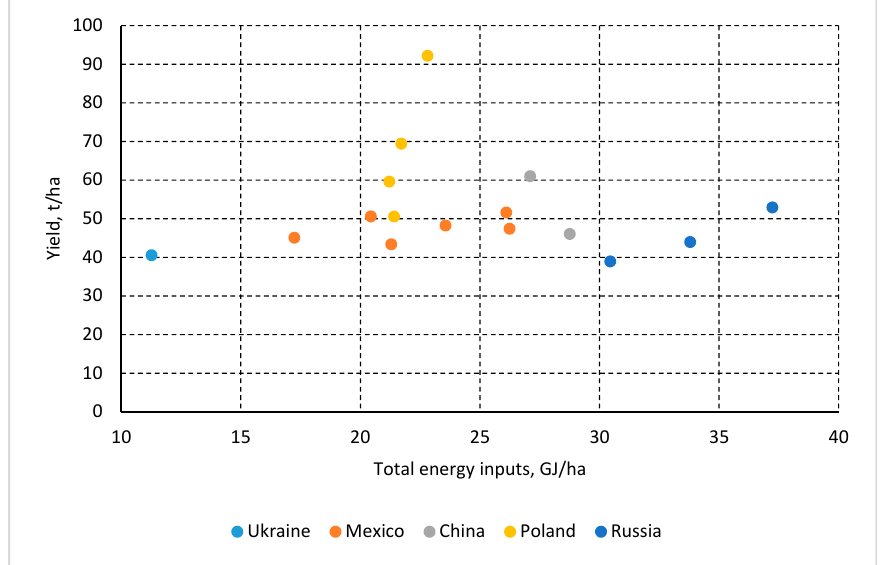
Figure 8. Yield versus total energy consumption.